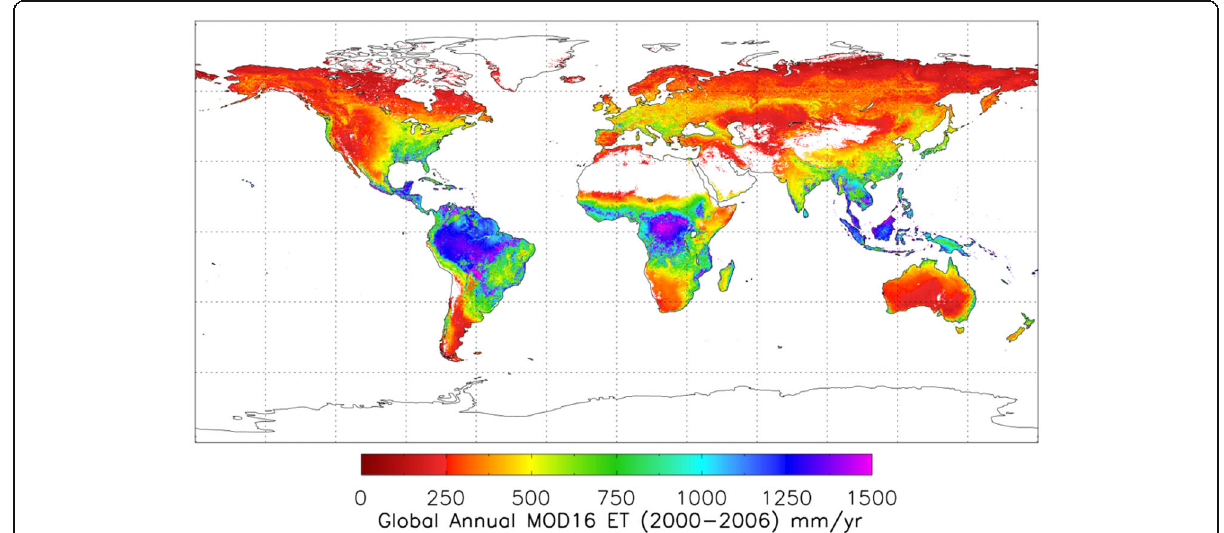
Fig. 5 Example of the MOD16 evapotranspiration (ET) product, showing the average annual ET for a 7-year period (from